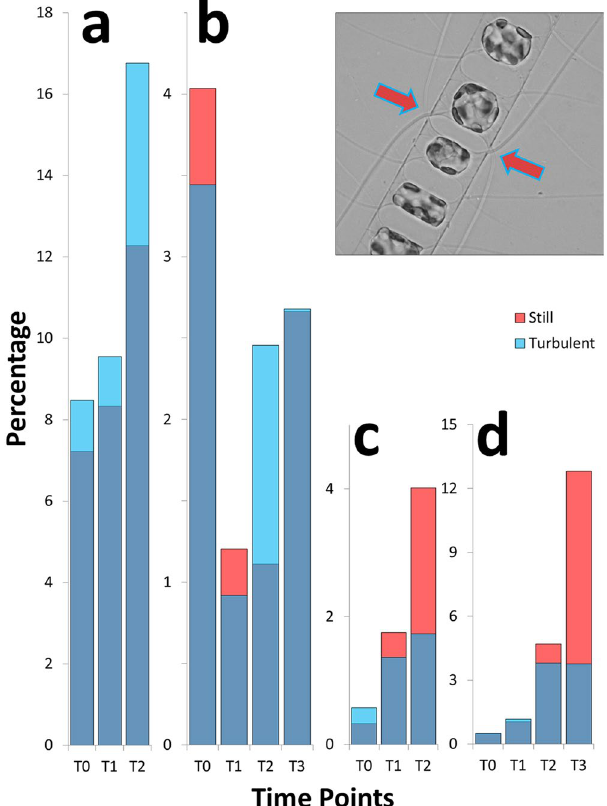
Figure 4. Frequency of separating chains ( a , b ) and mechanically broken chains ( c , d ) in C. decipiens . ( a , c ) experiment 1; ( b , d ) experiment 2. On the x-axis time points are reported, on the y-axis the frequency of separating ( a , b ) and mechanically broken ( c , d ) chains expressed as percentage are reported. Colour code follows Fig. 3. Inlet: a separation point with two adjacent separating cells. Arrows indicate thicker terminal setae produced by the separating